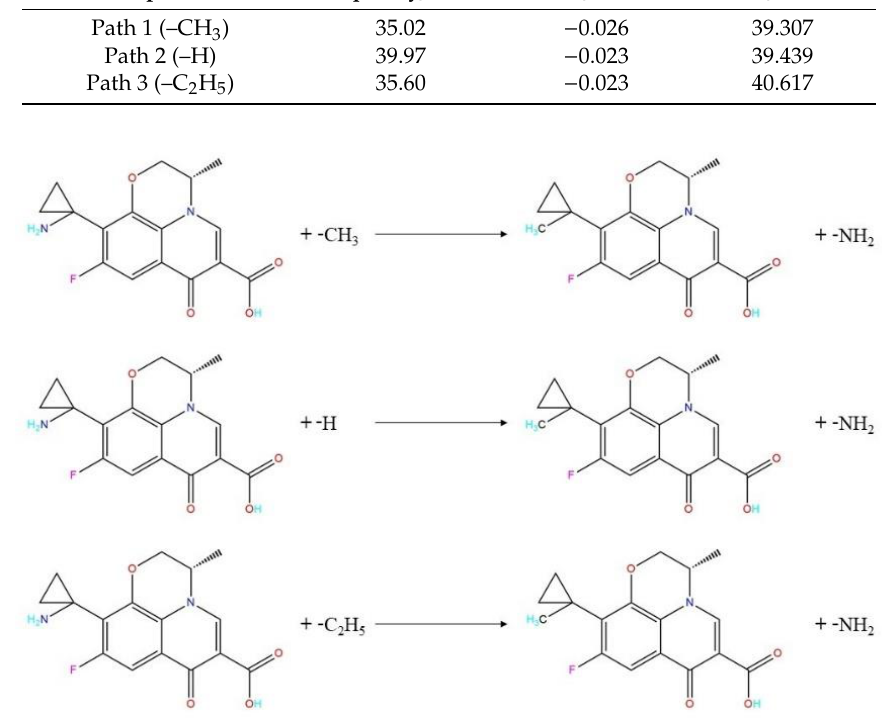
Figure 8. The substitution reaction paths of PAZ.